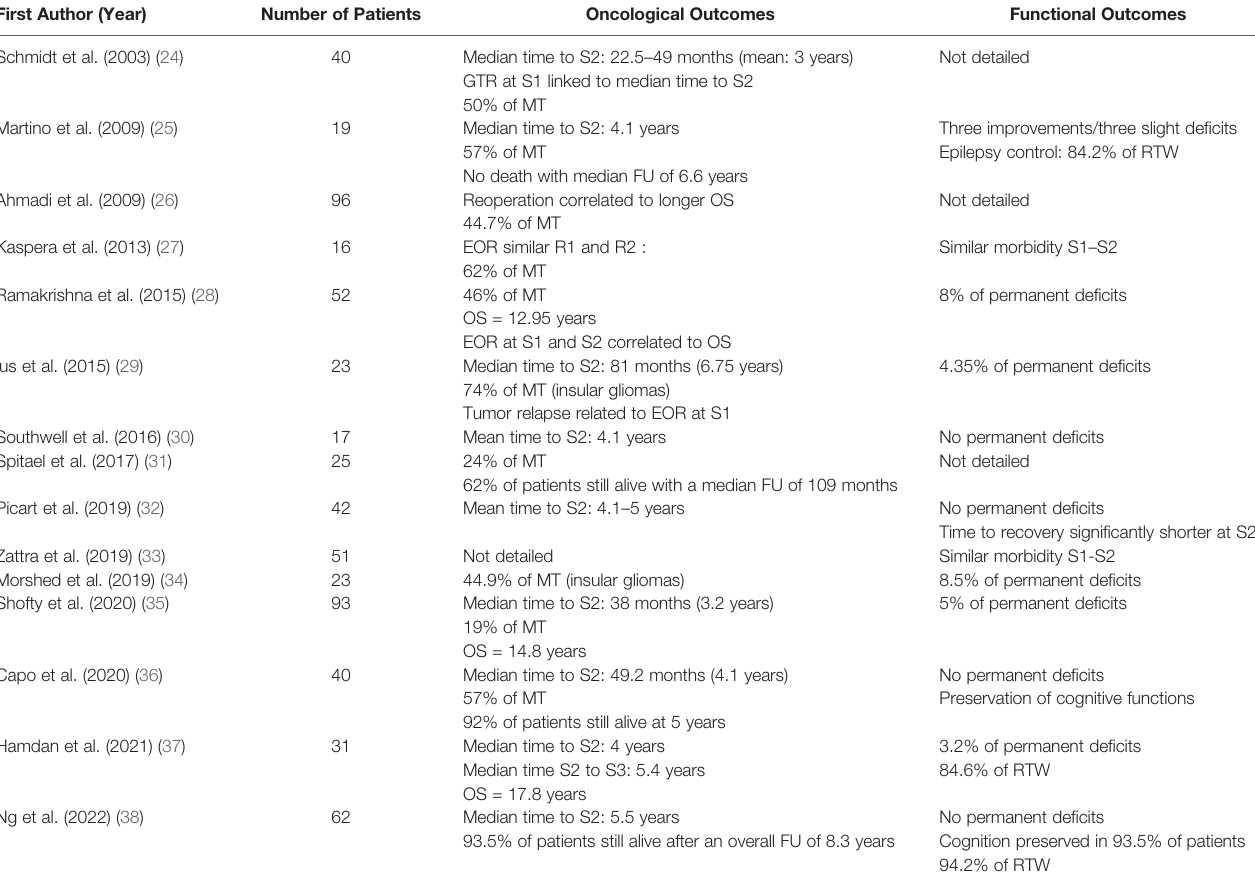
TABLE 1 | Original series that reported outcomes following reoperation in patients with